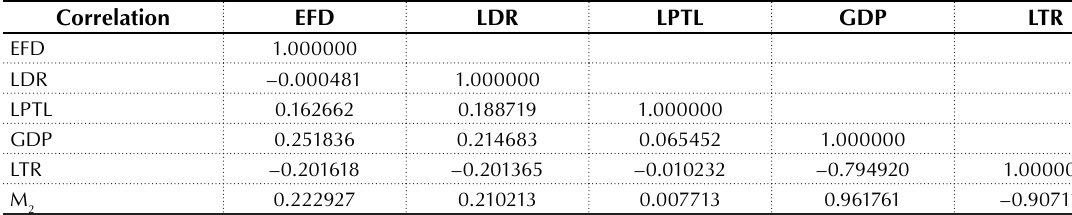
Table B2. Correlation matrix of the variables